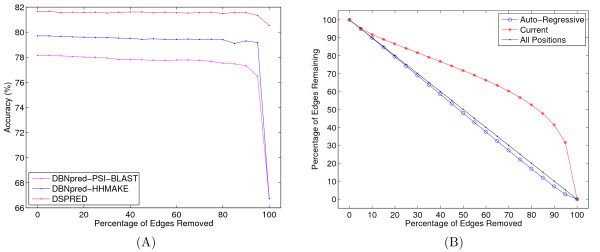
The effects of sparsification. (A) The figure plots accuracy as a function of the percentage of dlinks eliminated. Dlinks are the weight parameters that are assigned to the edges in the graphical model representation of the DBN. In an auto-regressive model, the majority of the model parameters become dlink coefficients. It is possible to remove significant proportion of the dlinks while maintaining the overall predictive accuracy such that 70% of the dlink parameters can be removed for the DBN model that uses PSI-BLAST PSSMs only, 80% of the dlink parameters can be removed for the DBN model that uses HHMAKE PSSMs only and the 95% of the dlink parameters can be removed for the DSPRED method (DBN combined with SVM) that uses PSI-BLAST PSSMs, HHMAKE PSSMs and posterior distributions of secondary structure labels. (B) The figure plots the percentage of dlinks that are retained as a function of the sparsity of the model. The three series correspond to all dlinks, only the current dlinks and only the auto-regressive dlinks. In the auto-regressive and the current series, the percentages are computed with respect to the total number of dlinks within each of these series separately. For both panels, results are computed via seven-fold cross-validation on SD576. The hyperparameters of the DBN are LAA = 5, LSS = 3, α = 0.035, ω = 0.4.